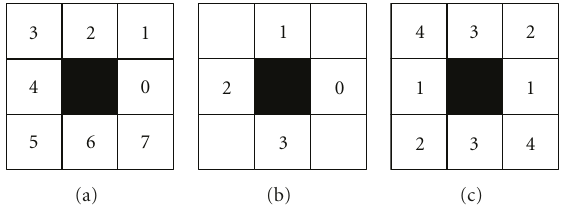
Figure 5: D-Coding structure. (a) The 8-direction Freeman coding structure, (b) the 4-direction Freeman coding structure, and (c) the proposed D-Coding